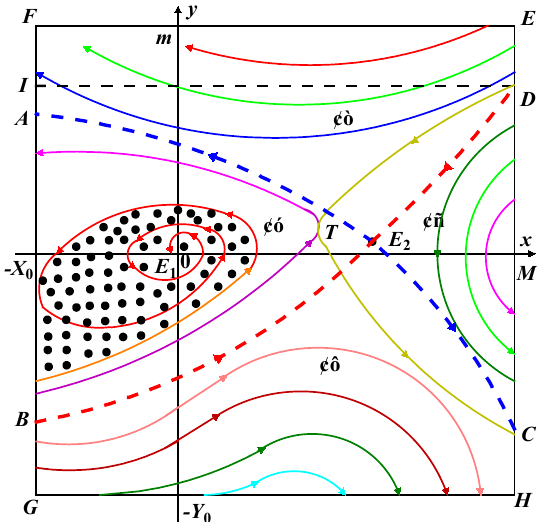
Figure 1. Asymptotically stable situation of the odd point E 1 (0, 0).